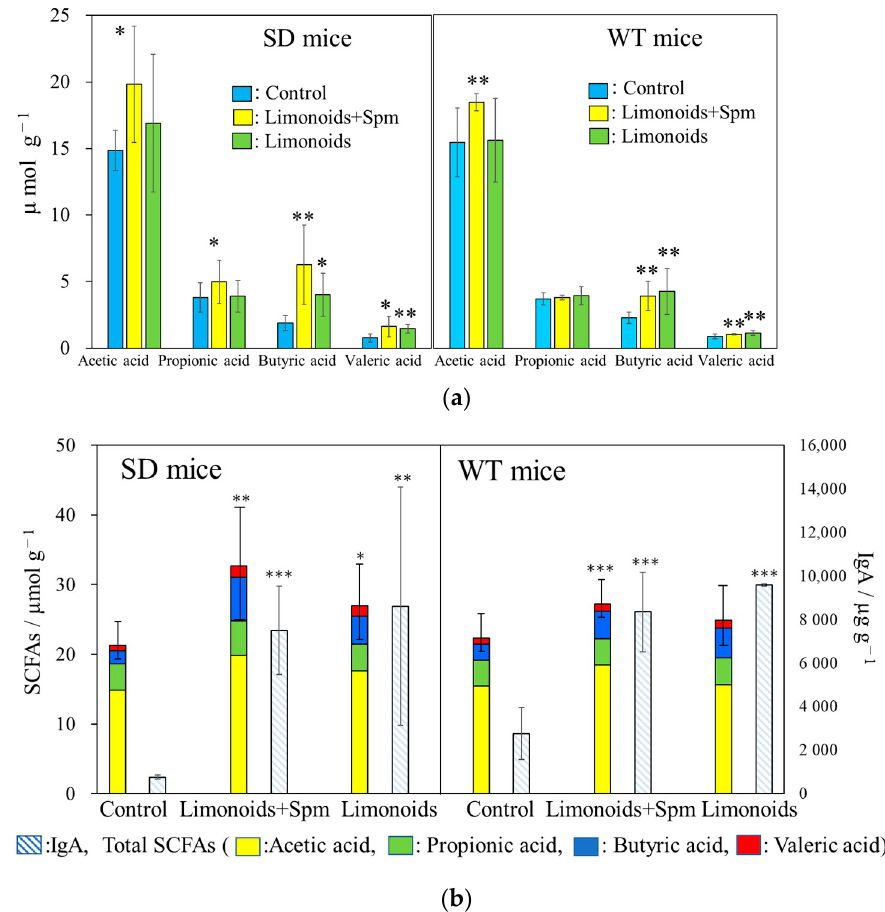
Figure 6. Short-chain fatty acid (SCFA) content ( μ mol g − 1 ) ( a ) in feces from SD or WT mice ( b ) and comparison of immunoglobulin A (IgA) production ( μ g g − 1 ) vs. total SCFA content. SD and WT mice were treated at 12–14 weeks of age (WT mice; n = 9/each group, SD mice; n = 15/each group). Values represent means ± S.D. Data onto a bar graph are plotted in comparison to the controls for clarity; * p ≤ 0.05; ** p ≤ 0.01; *** p ≤ 0.001. The correlation coefficient between the levels of SCFAs and IgA, r = 0.52, p 0.05. SD, Sandhoff disease; WT, wild-type.